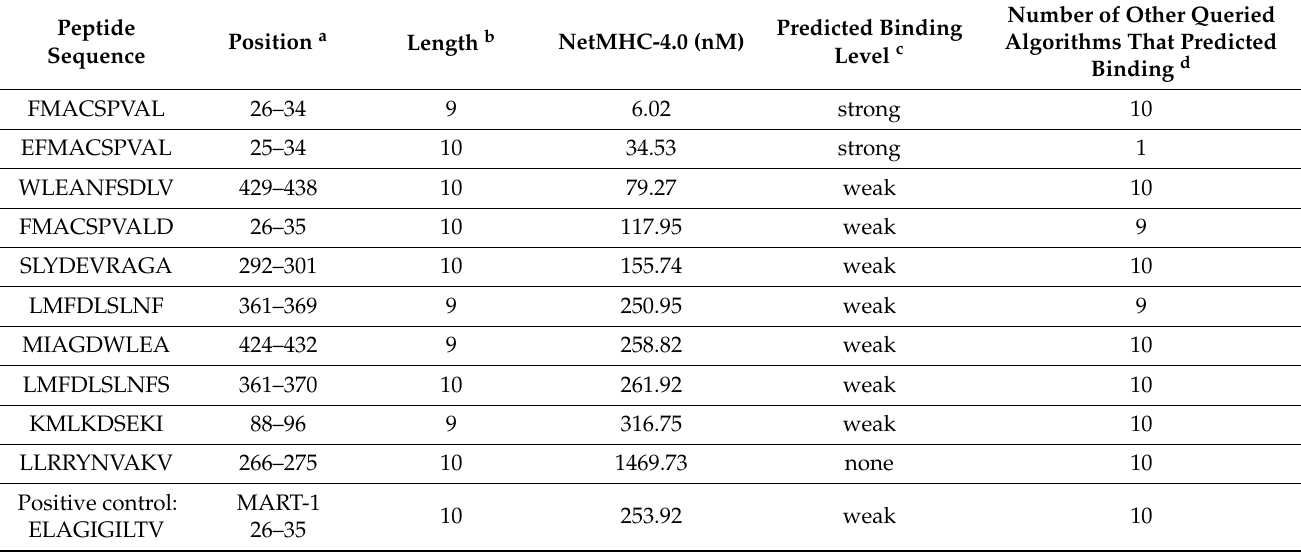
Table 1. HLA-A*0201-binding peptides derived from SOX11 as defined by in silico